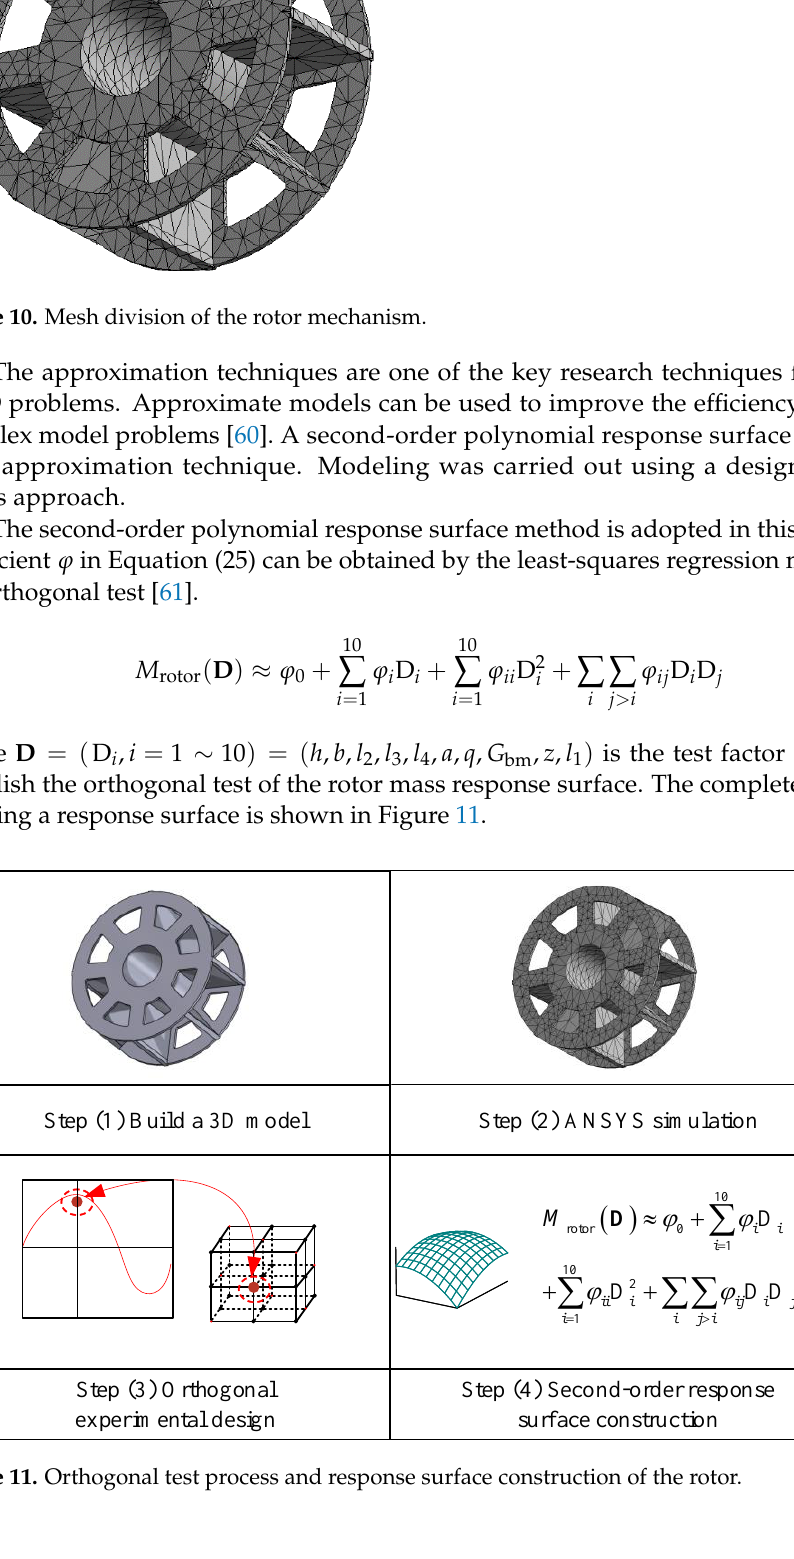
Figure 9. 3D model of the rotor mechanism.